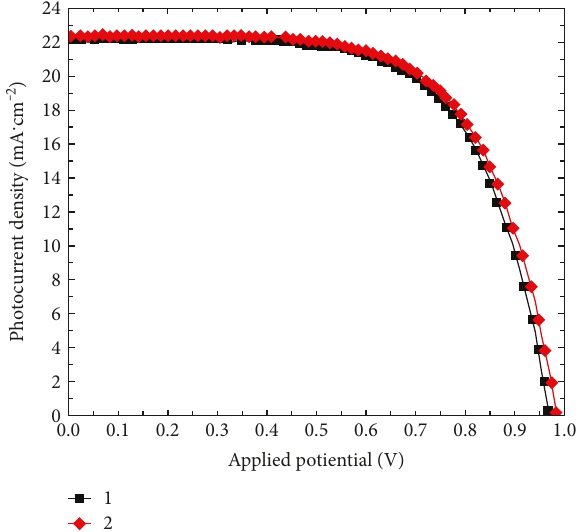
layer with two di ff erent annealing programs, 2